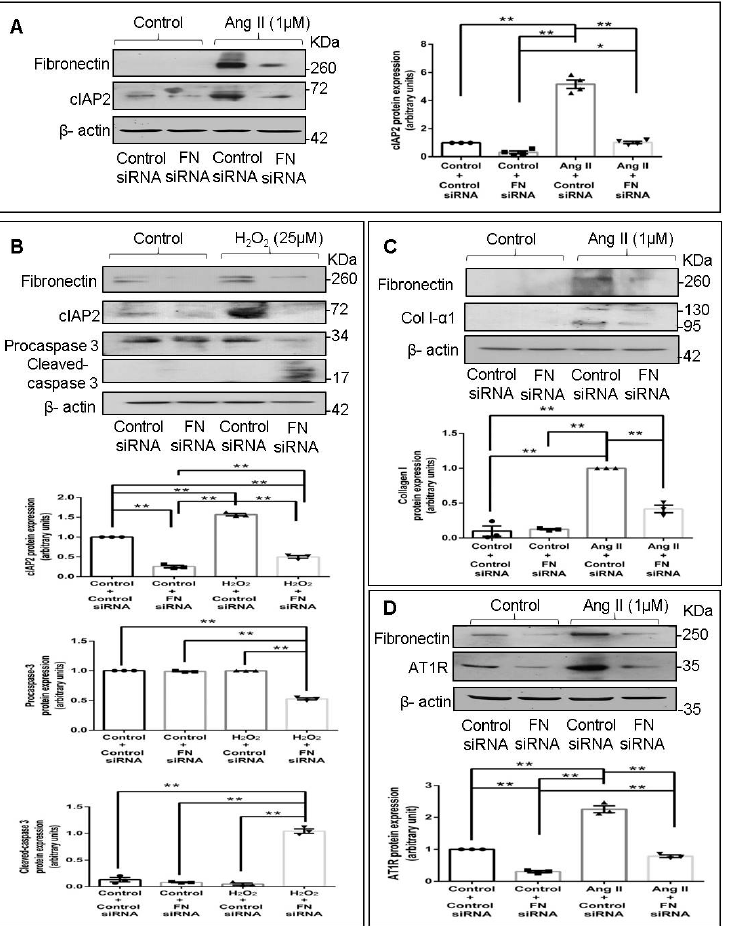
Figure 3. Fibronectin mediates Ang II-stimulated protein expression of cIAP2, collagen type I, and AT1R in cardiac fibroblasts. ( A ) Cardiac fibroblasts were transiently transfected with fibronectin siRNA (20 pmol) or control (scrambled) siRNA prior to treatment with Ang II for 12 h. cIAP2 protein expression was examined, with β -actin as loading control. Validation of fibronectin silencing is also shown. * p < 0.05 and ** p < 0.01 (comparisons as depicted in the Figure). ( B ) Cardiac fibroblasts were transiently transfected with fibronectin siRNA (20 pmol) or control (scrambled) siRNA. Following treatment of cells with 25 µM H 2 O 2 for 3 h, the cells were collected, and levels of procaspase 3 and cleaved-caspase 3 were determined, with β -actin as loading control. Validation of fibronectin silencing and associated changes in cIAP2 levels are also shown. ** p < 0.01 (comparisons as depicted in the figure). (C, D) Cardiac fibroblasts were transiently transfected with fibronectin siRNA (20 pmol) or control (scrambled) siRNA prior to treatment with Ang II for 12 h. ( C ) Collagen type 1 protein expression was examined with β -actin as loading control. Validation of fibronectin silencing is shown. ** p < 0.01 (comparisons as depicted in the Figure). ( D ) AT1R protein expression was examined, with β -actin as loading control. Validation of fibronectin silencing is shown. ** p < 0.01 (comparisons as depicted in the Figure). Data are representative of three independent experiments, n= 3. Mean ± SEM.